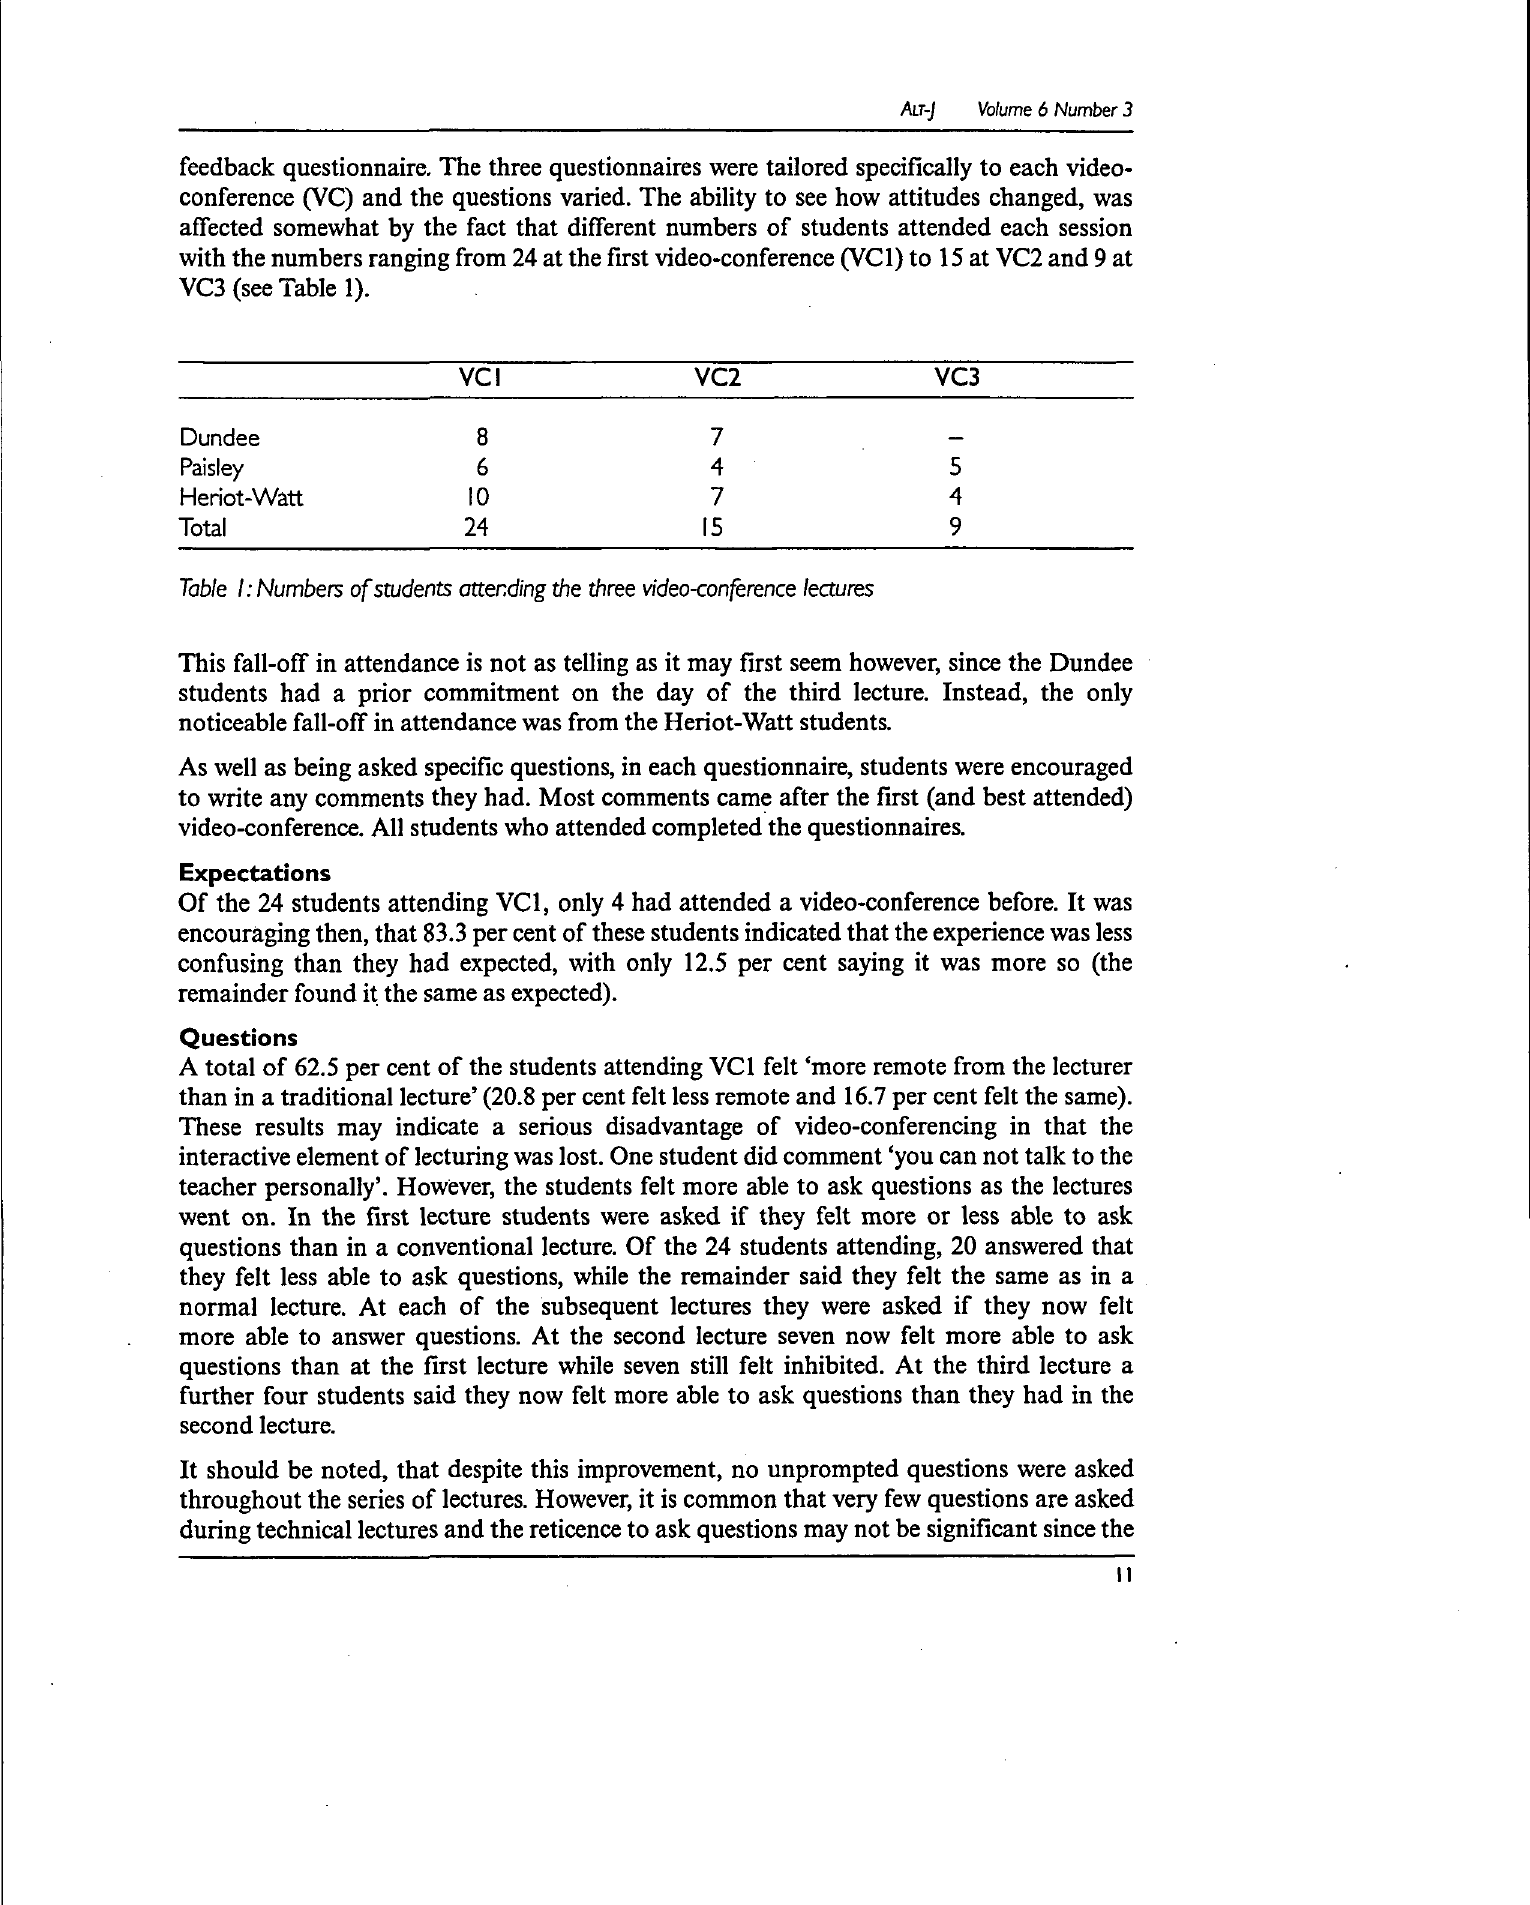
Table I: Numbers of students attending the three videcxonference